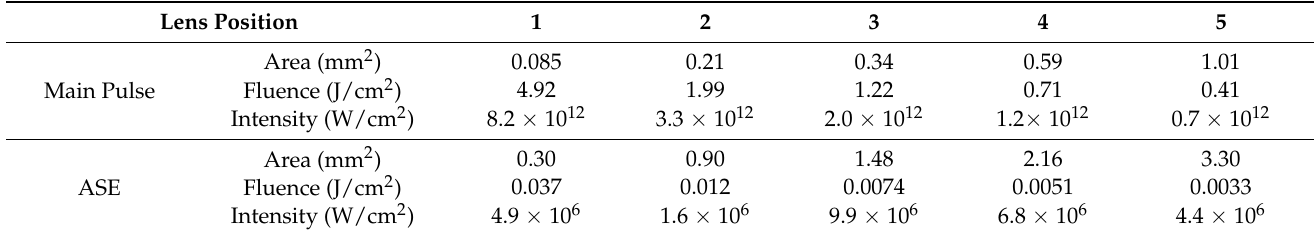
Table 1. The process parameter windows.